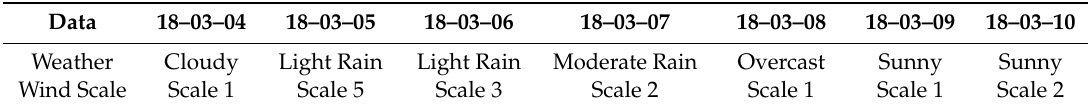
Table 4. Weather conditions during the